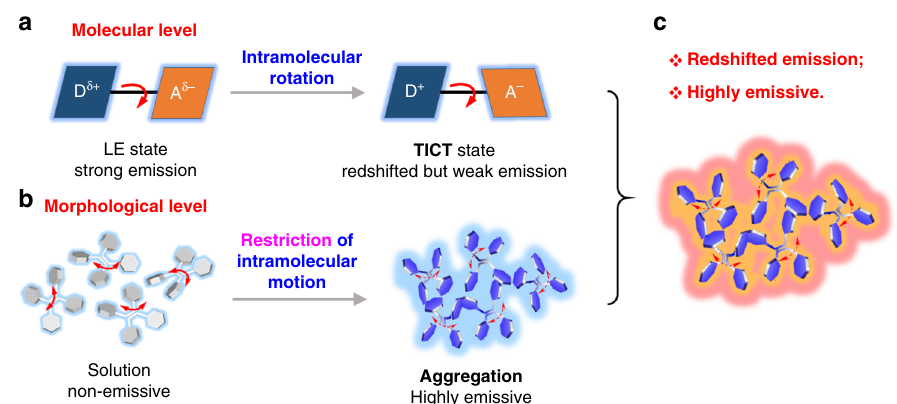
Fig. 1 Schematic illustration of emission mechanism. a The transition of the locally excited (LE) state to the TICT state by intramolecular rotation of the D- A units at the excited state (molecular level). b The mechanism of AIE through restriction of intramolecular motion (morphological level). c The combination of TICT and AIE in the aggregate state.